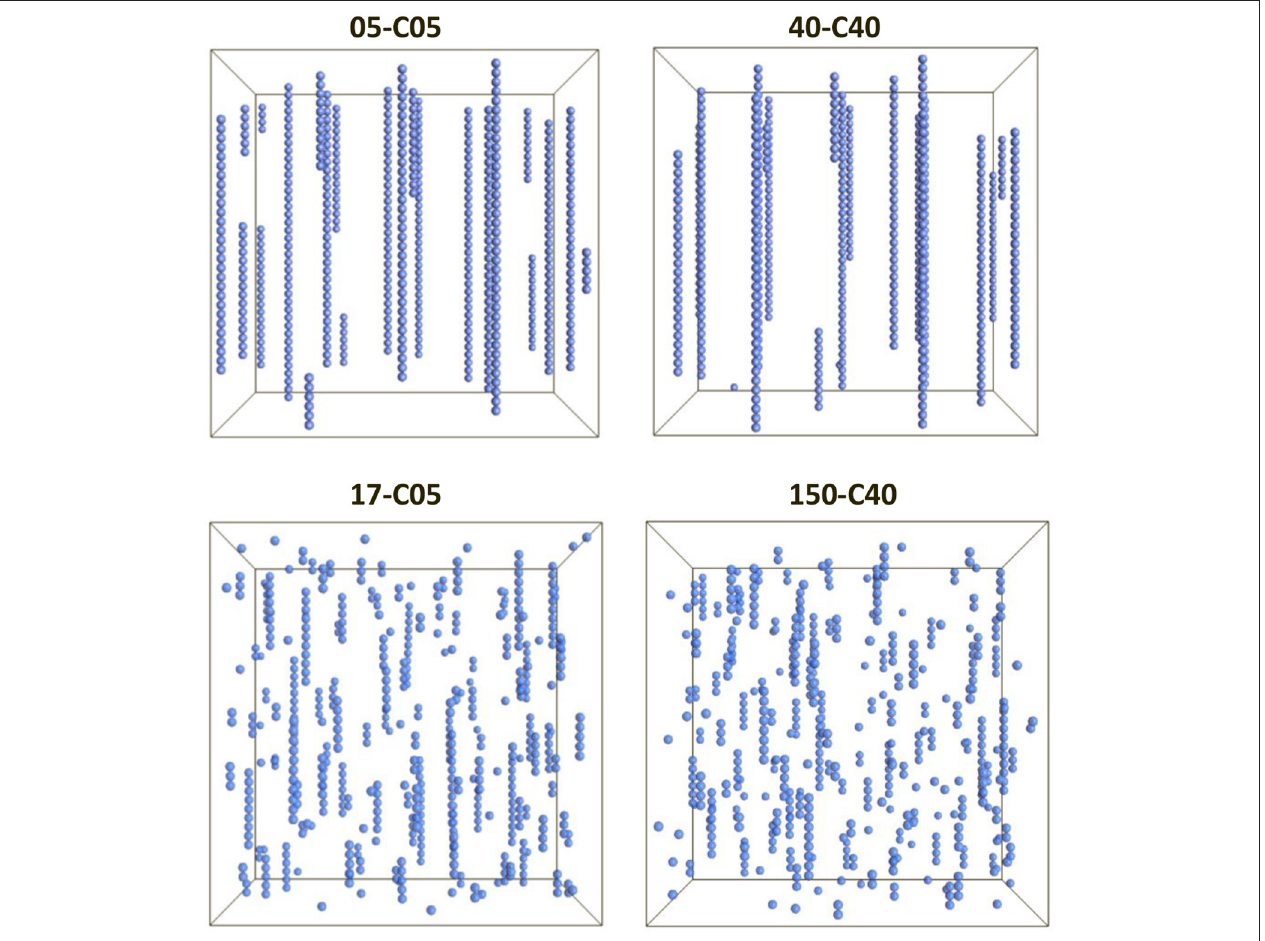
FIGURE 1 | Visualization of 4 cases corresponding to two different core sizes (0.5 and 4.0 µ m, left and right respectively) and situations in which no shell was present, and thus RST = 0 (top) or a thick shell was present (RST = 0.70, bottom left and RST = 0.73, bottom right). The images have been scaled for easier viewing. However, the dimensions of the system were different to keep a constant volume fraction of